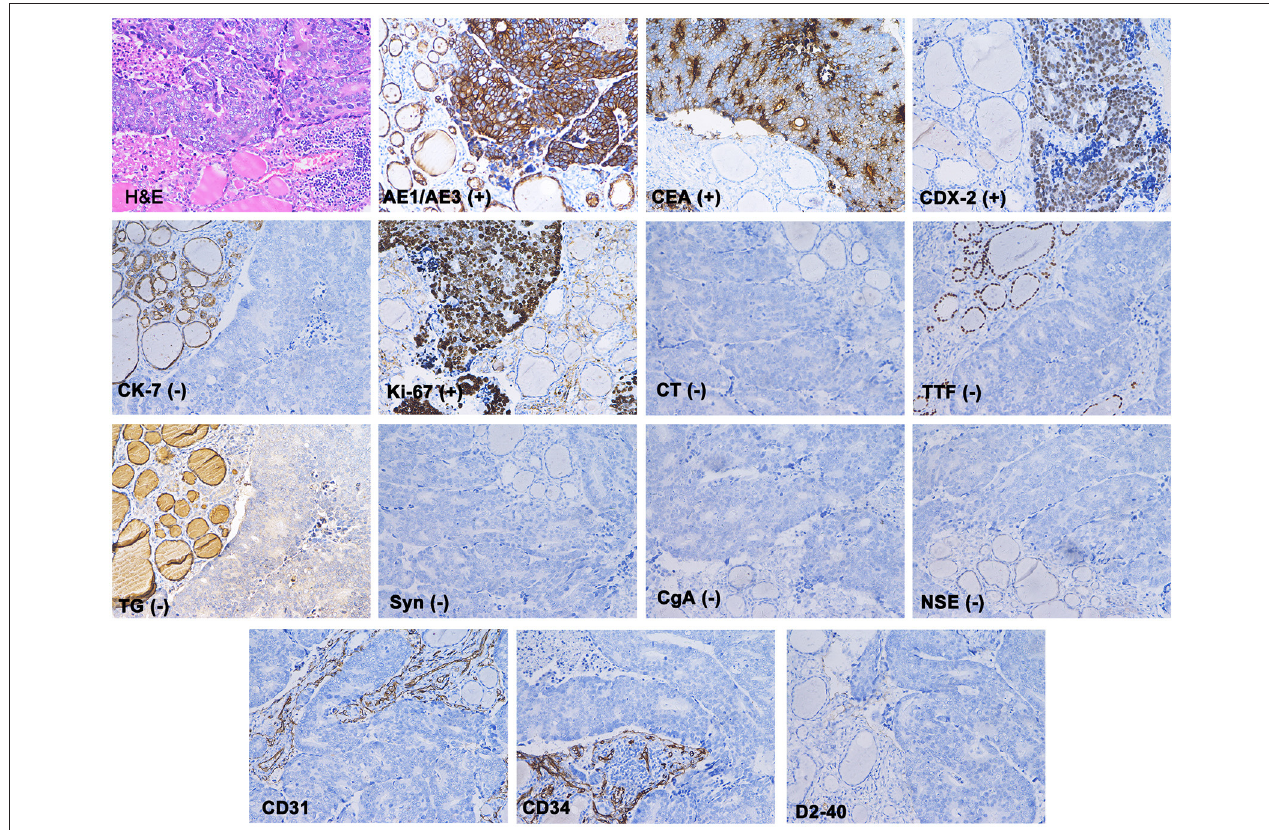
FIGURE 3 | Haematoxylin and eosin staining showed that the normal thyroid follicles had been destroyed by dispersed tumor cells. Immunohistochemistry showed that AE1/AE3, CEA and CDX-2 stained positive, while CK7, TG, TTF, CT, Syn, CgA, and NSE were absent. The blood vessels (marked with CD31 and CD34) and lymphatic vessels (marked with D2-40) were found to be filled with tumor